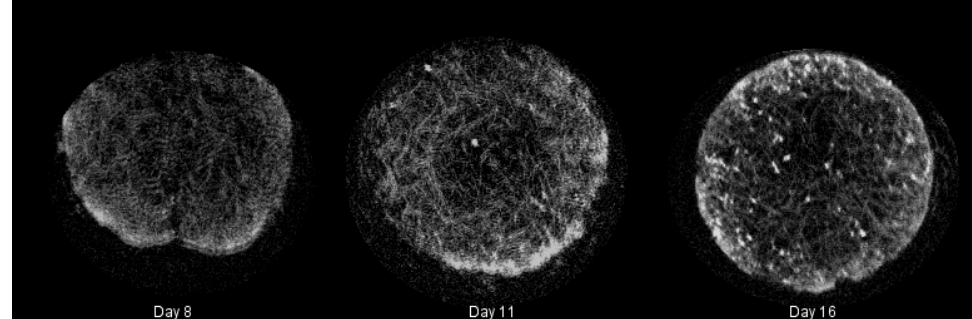
Figure 3. Summary of mineralized tissue (hard extracellular matrix (ECM)) deposited in cultured constructs rendered during microcomputed tomography ( µ CT) with Simple Viewer for samples taken on Days 8, 11 and 16, respectively.